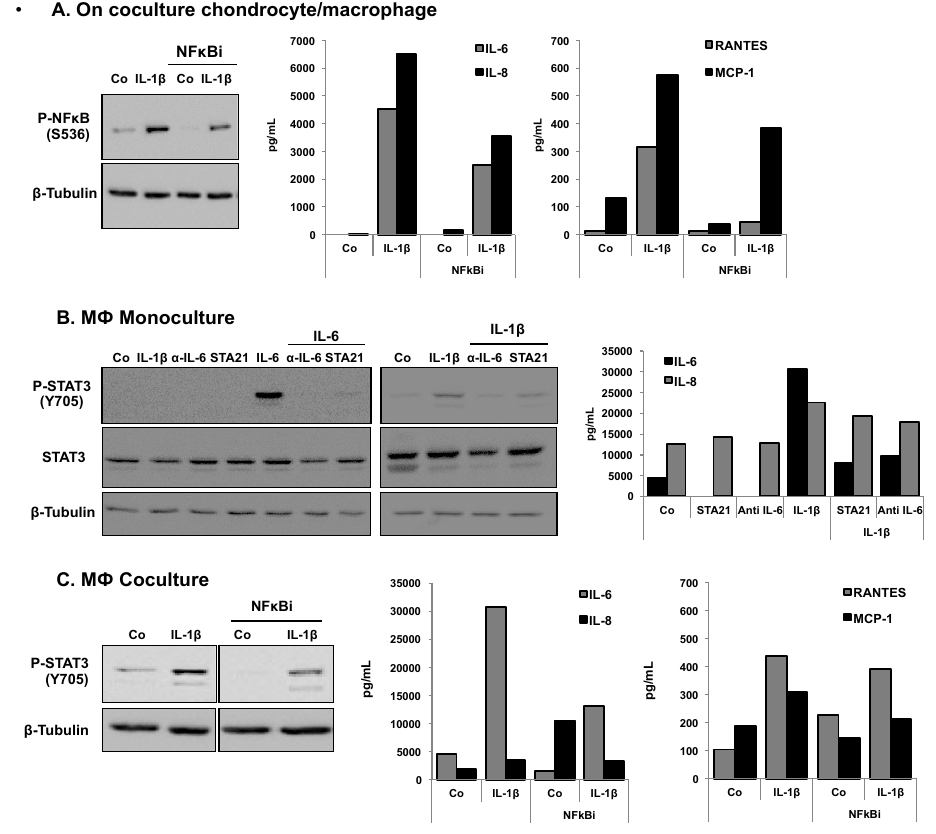
Figure 2. Effects of a NF- κ B inhibitor on the levels of p-NF- κ B and p-STAT3 and on the levels of secreted IL-6, IL-8, Rantes and MCP-1 in HcH, M Φ cultures or in HcH/M Φ coculture. ( A ) Effect of a NF- κ B inhibitor on the level of p-NF- κ B (Western blot) and on the levels (ELISA) of IL-6, IL-8, Rantes, MCP-1 in HcH cultures and the effect of IL-1 β treatment. Representative data from one of three experiments are shown; ( B ) Levels of p-STAT3 were determined by Western blotting) and the levels of IL-6 and IL-8 were determined by ELISA assay, in M Φ cultures. Effect of treatment with IL-1 β , IL-6, aIL-6 or STA21. Co, control. Representative data from one of three experiments are shown; ( C ) Expression of p-STAT3 (Western blotting) and on the level (ELISA) of IL-6, IL-8, Rantes, MCP-1 in M Φ cocultures. Effect of IL-1 β and NF- κ B inhibitor. β -Tubulin: protein loading control, Pg/mL: picogram/mL. Representative data from one of three experiments are